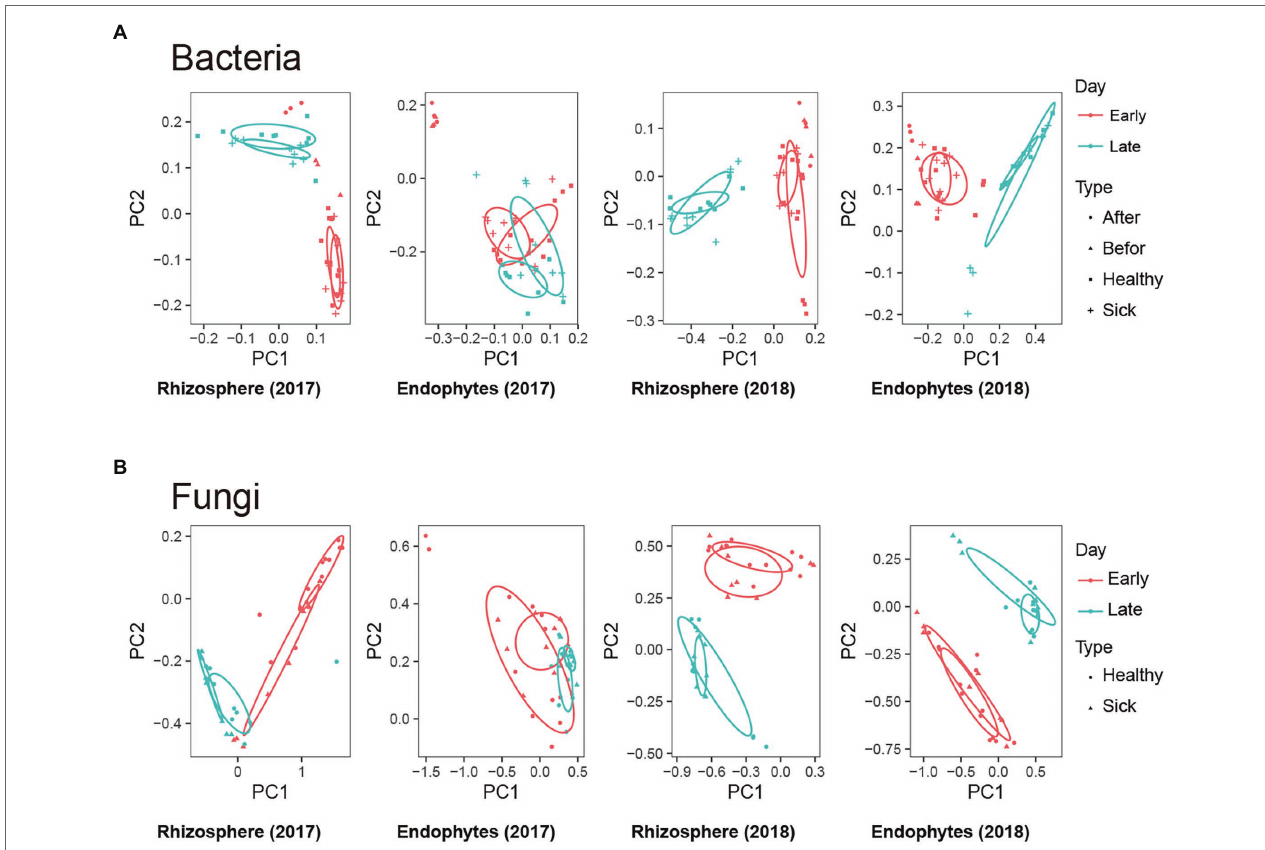
FIGURE 2 | Effects of root-knot nematode (RKN) infection on tobacco root microorganisms. (A,B) Representative tobacco rhizosphere bacteria, endophytic bacteria, rhizosphere fungi and endophytic fungi based on a weighted UniFrac algorithm of PCoA analysis. Early: 0–45 days, Late: 45–90